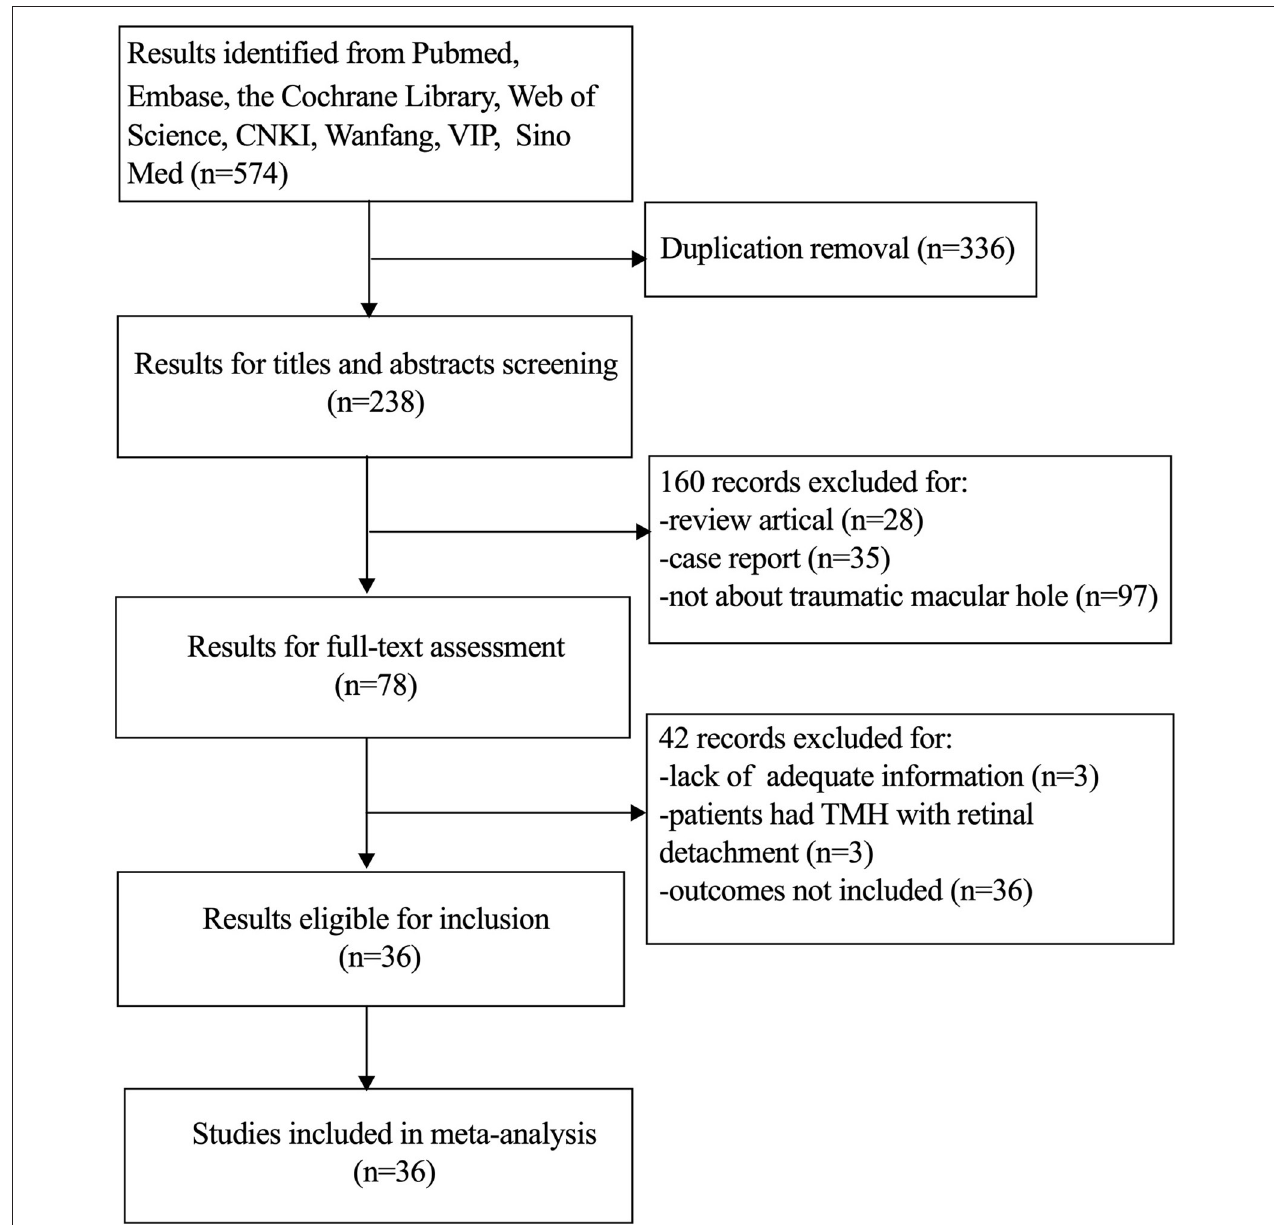
FIGURE 1 | Flow chart of the study selection (through June 10,